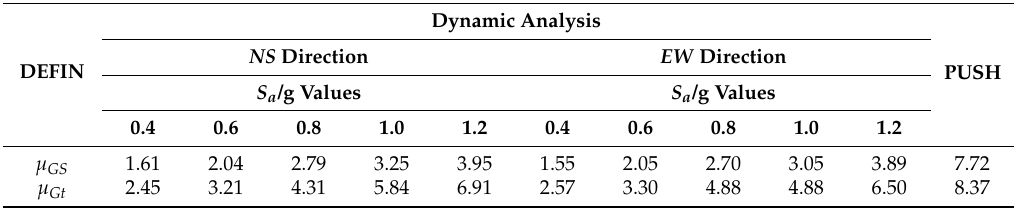
Table 8. Global ductility ( µ GS y µ Gt ), 3-level building.